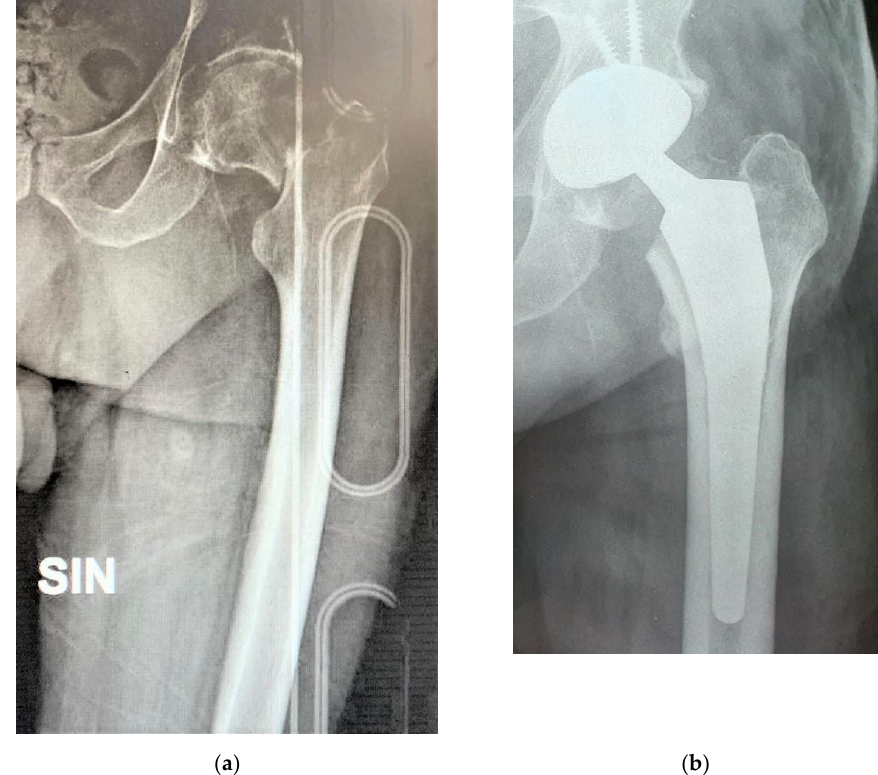
Figure 2. Displaced fracture of left femoral neck in a 54 years old male ( a ); dual mobility (DM) modular cup with screw and cementless stem ( b ).